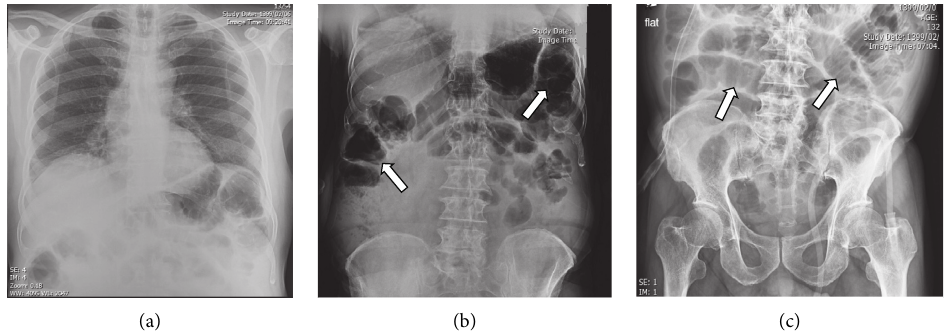
Figure 1: The patient’s chest X-ray: (a) no significant finding in chest X-ray; (b) colon is visible; (c) dilated small bowel